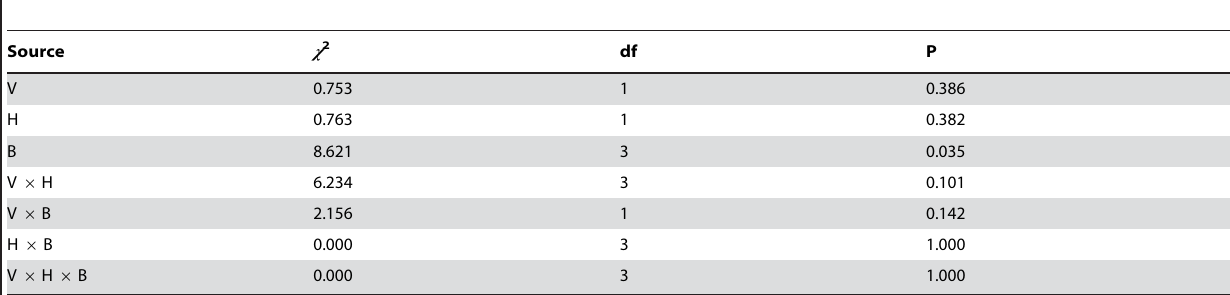
Table 4. Effects of water volume (V), water heterogeneity (H), and belowground herbivore (B) on plant mortality.